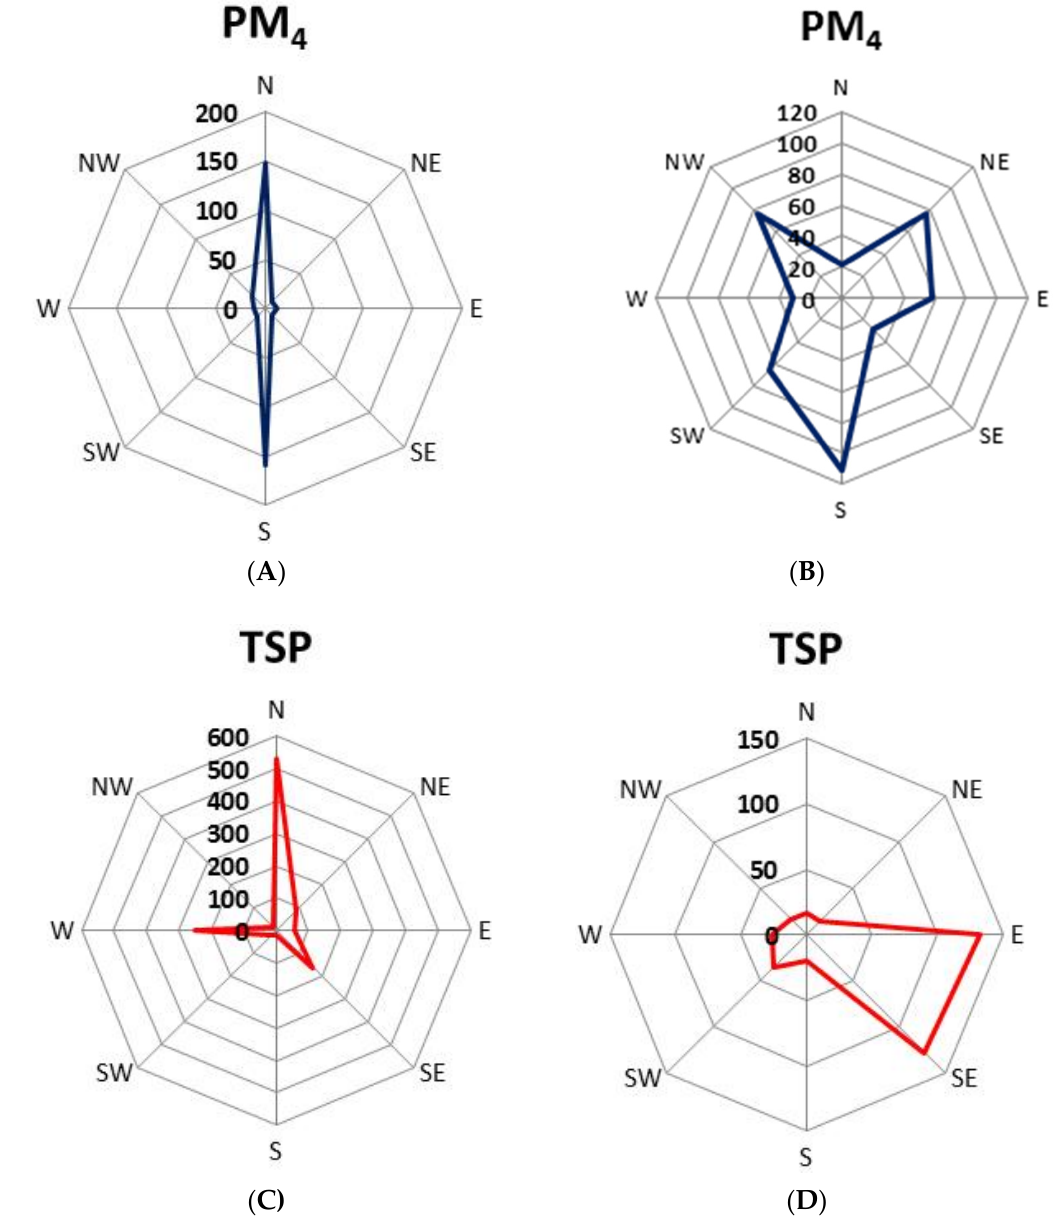
Figure 3. PM4 and TSP concentration roses for two measurement periods (( A , C ) for the period 1–26 September; ( B , D ) for the period 29 September–31 October). Concentrations of PM4 and TSP are in µg/m 3 .